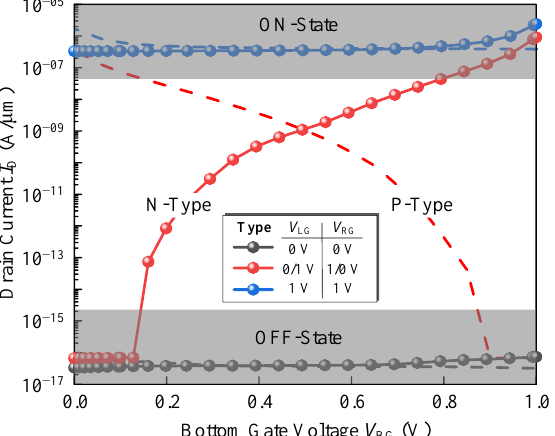
Figure 7. I - V characteristics of the N-type and P-type MAJ logic transistor at V DS = 1 V. The BTBT generation distribution in the inverted T channel at different gate inputs reveals different on-state mechanisms, as shown in Figure 8. Taking the condition of ABC = “110” as an example (Figure 8b), the BTBT only occurs in the vertical channel, and thus the drain current flows through the vertical region. Due to the strong coupling, the BTBT in the horizontal channel is suppressed, resulting in an almost zero BTBT generation rate in this region. The different gate inputs lead to distribution differences of the BTBT, which shows the channel strobe mechanisms of the proposed device.